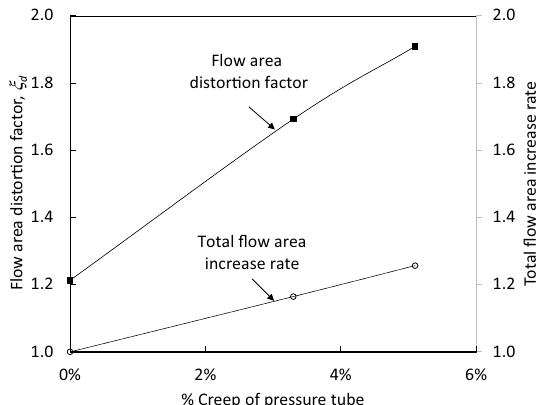
Fig. 3. Axial pro fi le of the pressure tube diameter creep [1]. Fig. 4. Flow area distortion according to the pressure tube